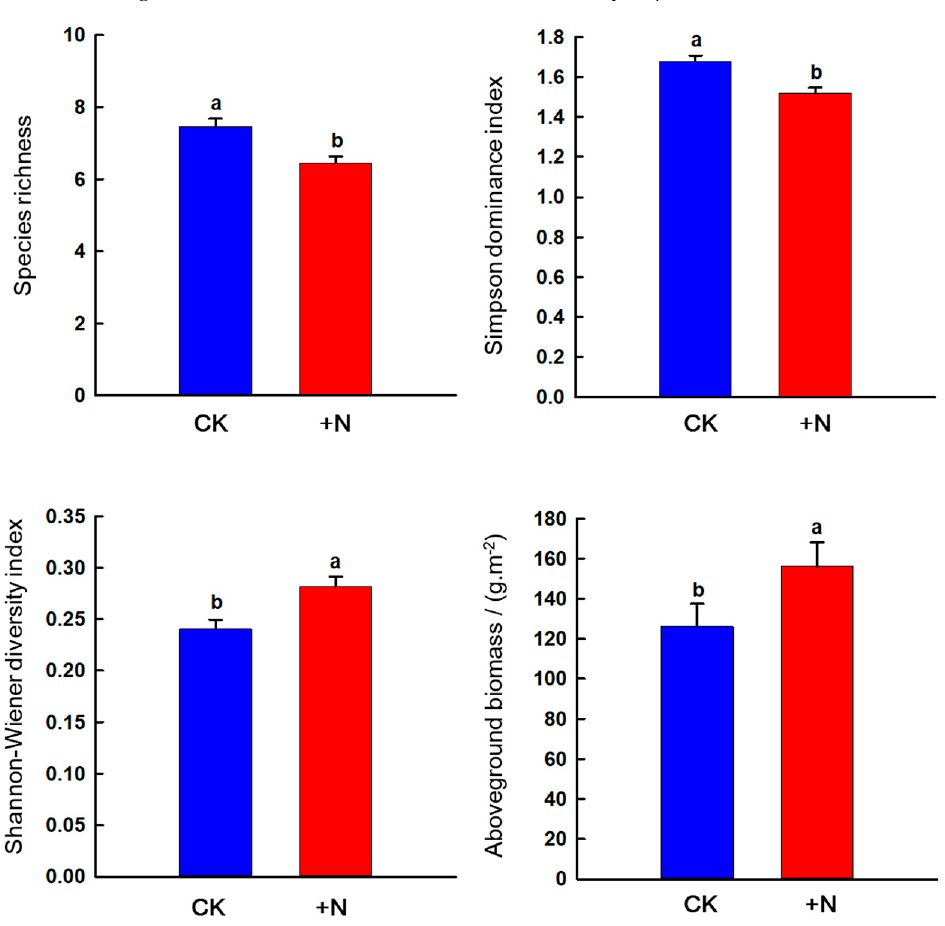
Figure 9. Effects of nitrogen addition on vegetation characteristics and aboveground biomass in the sandy grassland. Note: Different little letters indicate significant differences in nitrogen treatment ( p < 0.05).